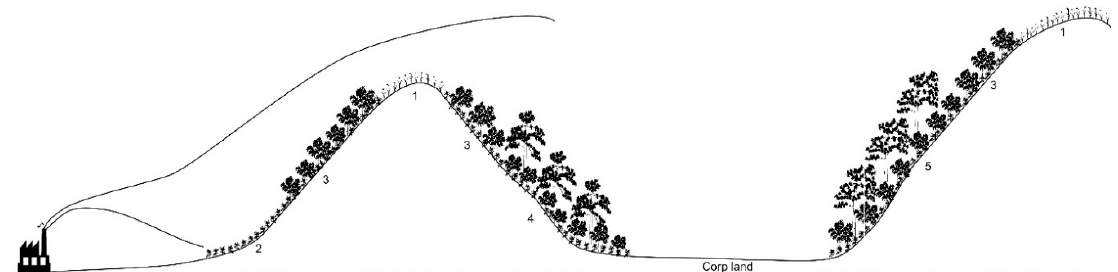
Figure 8. A diagram showing the spatial distribution of vegetation along the distance from pollution source and the topographic conditions in Yeocheon industrial complex. 1: M. sinensis var. purpurascens community; 2: P. americana community; 3: S. japonicus community; 4: P. thunbergii community; 5: P. densiflora community.